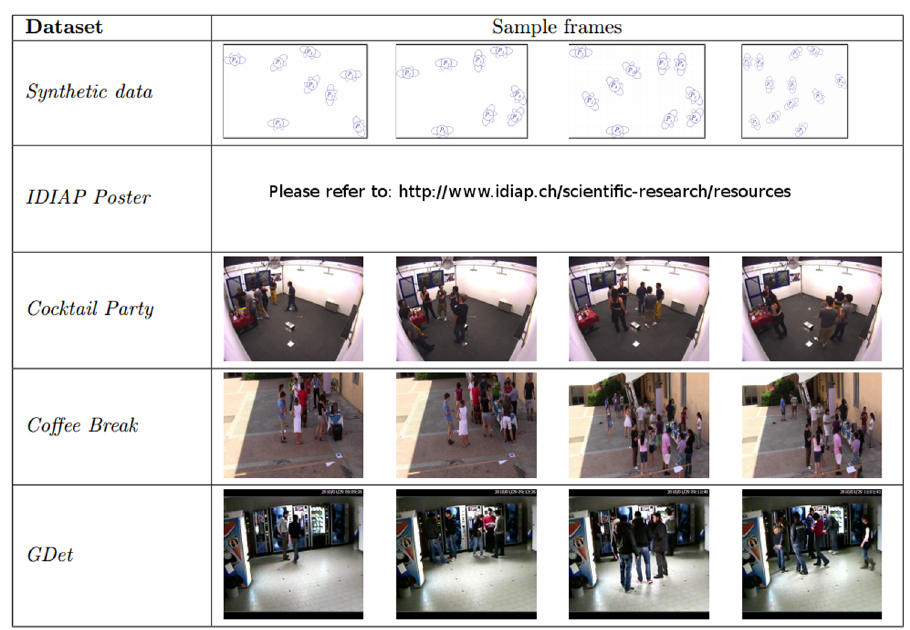
Fig 2. Sample images of the four real-world datasets. For each dataset four frames are reported showing different situations of crowd and arrangement.